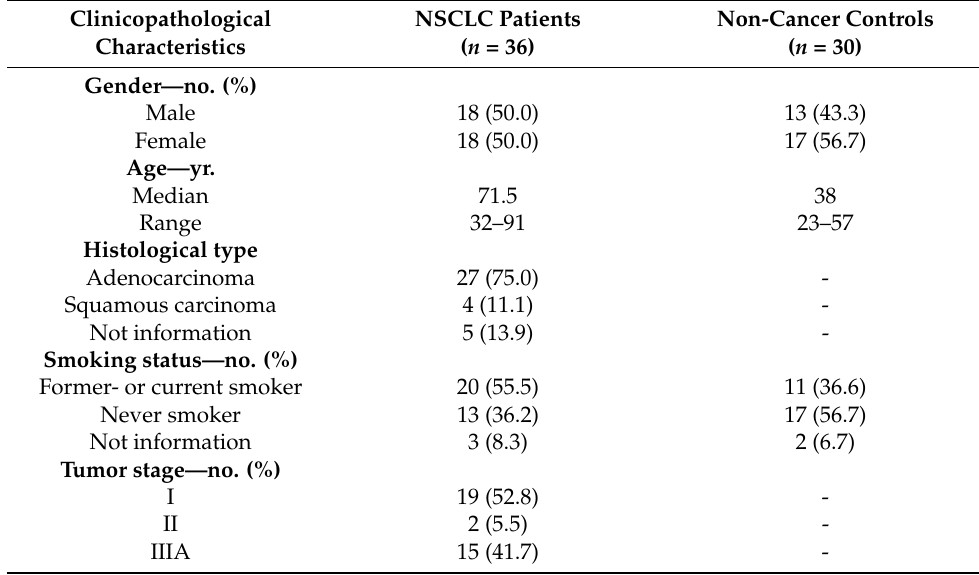
Table 1. Clinicopathologic characteristics of enrolled patients ( n =